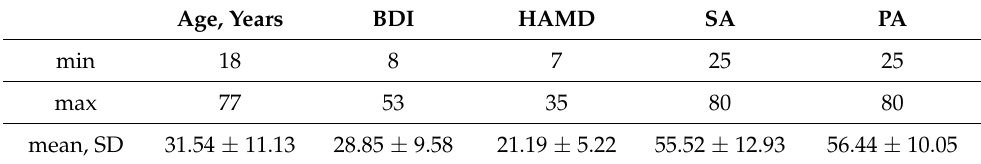
Table 1. Demographic and clinical characteristics of the patients with suicidal